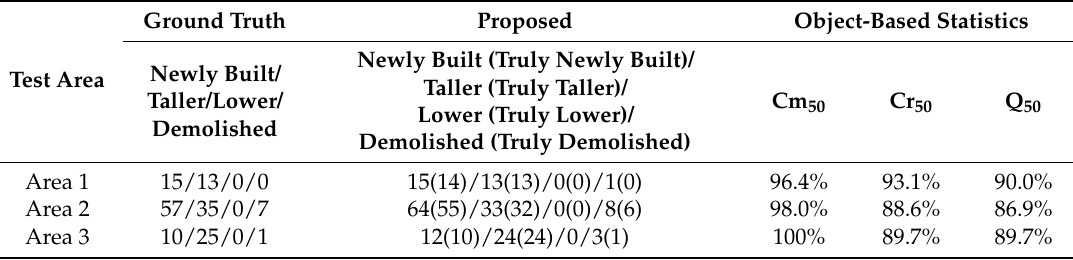
Table 5. Object-based statistics of building change detection in the three test areas with change types.